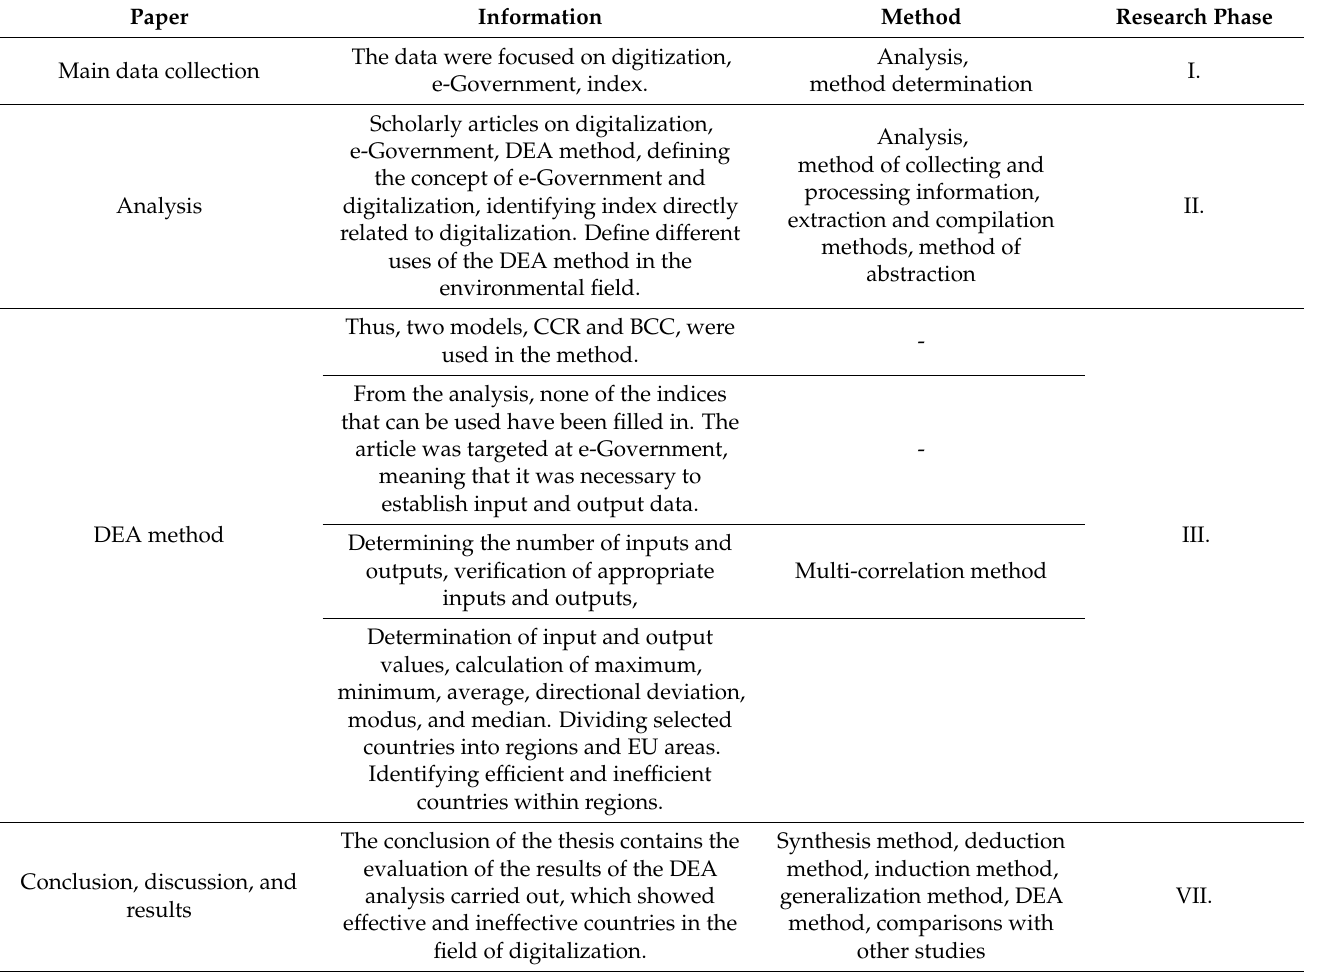
Table 6. Methodology of the